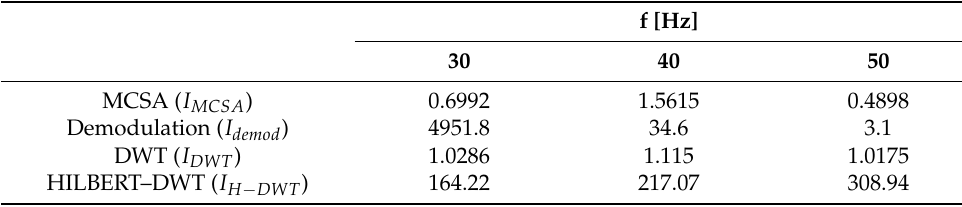
Figure 6. Value of the proposed diagnostic index I H − DWT in stationary conditions as a function of the requested torque, with f = 50 Hz. The stars state the simulated points, the blue line is the linear interpolation. Table 2. Diagnostic indexes at constant speed—variations in supply